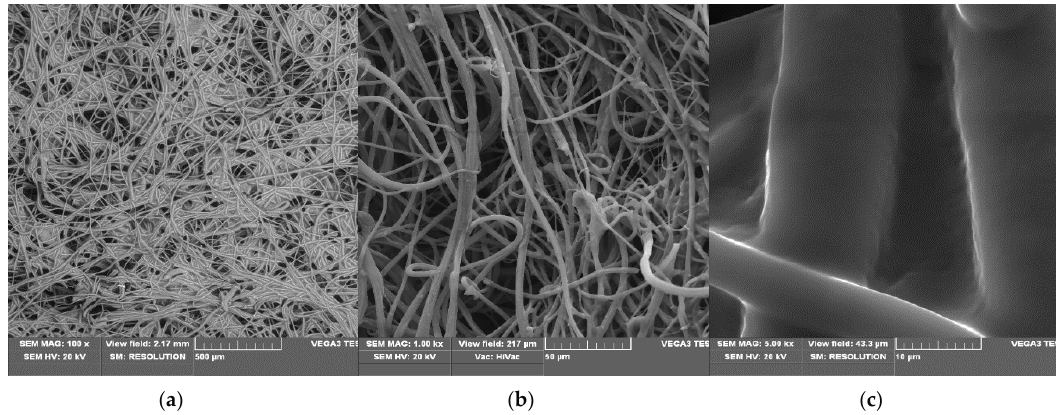
Figure 6. SEM images of PLA-SM composite, magnification: 100 × ( a ), 1000 × ( b ) and 5000 × ( c ). ( a ) (PLA-SM; SEM mag. × 100). ( b ) (PLA-SM; SEM mag. × 1000). ( c ) (PLA-SM; SEM mag. × 5000).